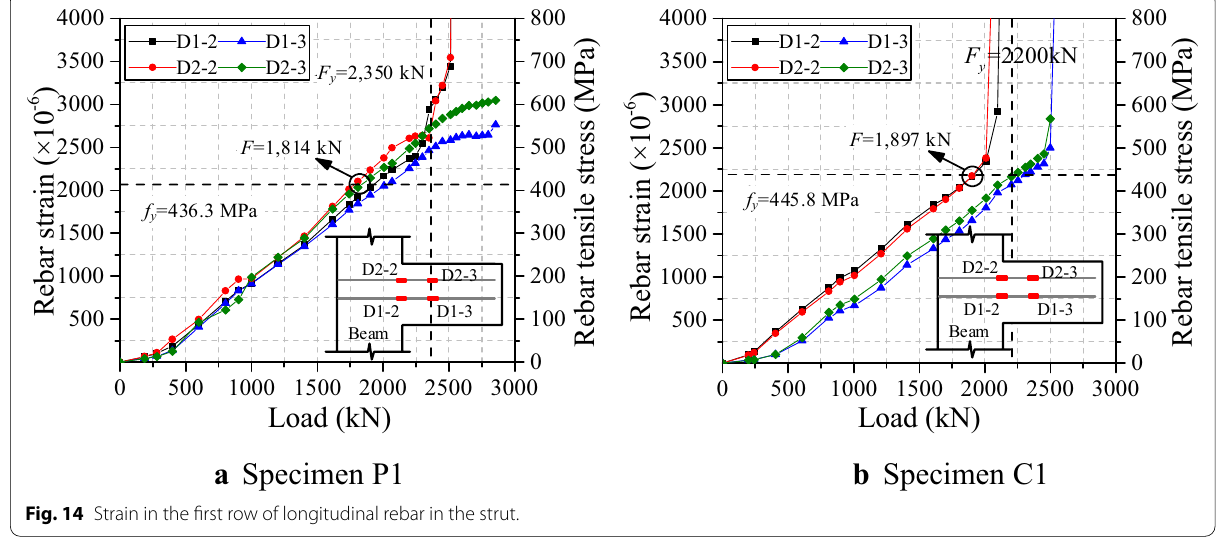
Fig. 14 Strain in the first row of longitudinal rebar in the strut.